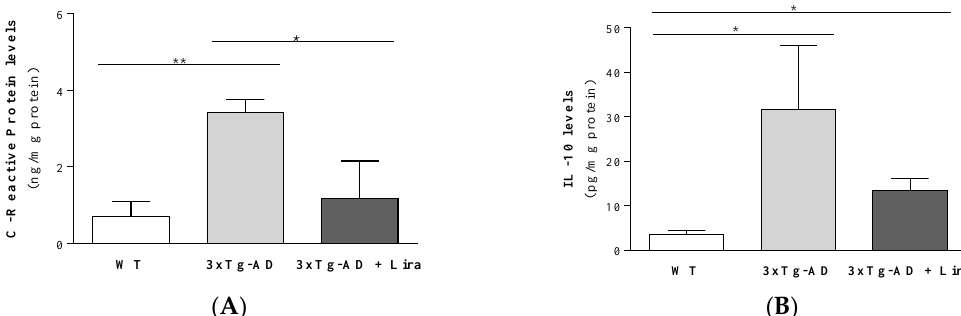
Figure 3. Effect of liraglutide on brain cortical inflammation markers in female mice with early AD-like pathology. Brain cortical C-Reactive Protein ( A ) and IL-10 ( B ) were determined. Data are the mean ± SE from 3–6 mice/group. Statistical significance: * p < 0.05 or ** p < 0.01, by the one-way ANOVA with the Fisher LSD or Games-Howell post-hoc tests for multiple comparisons.